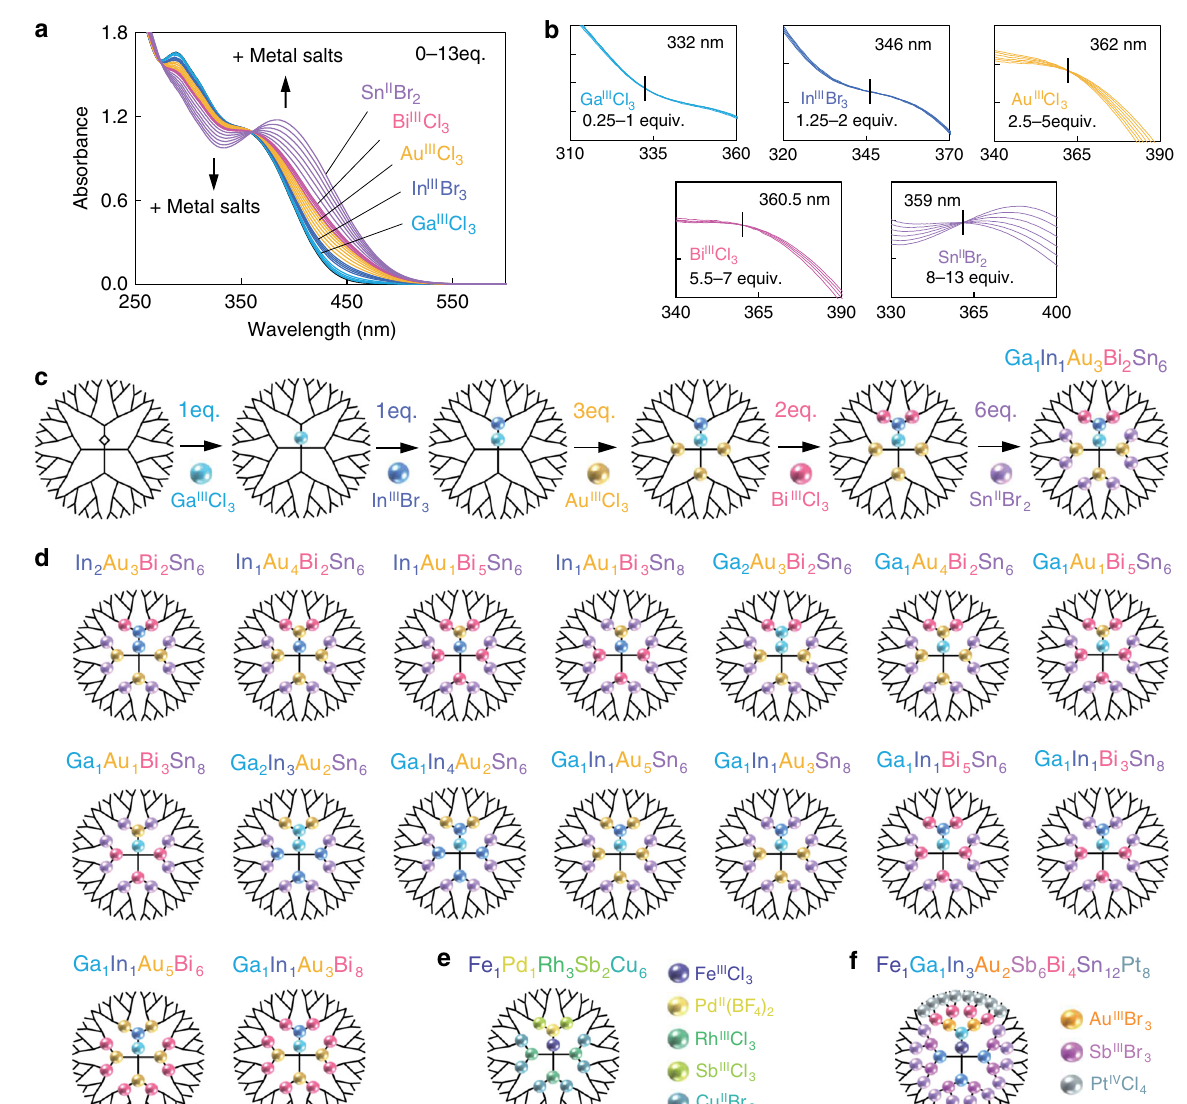
Fig. 3 Multimetallic accumulation on a dendrimer template. a Changes in UV-Vis absorption spectra of PyTPM-G4 upon addition of 1 equiv. Ga III Cl 3 , 1 equiv. In III Br 3 , 3 equiv. Au III Cl 3 , 2 equiv. Bi III Cl 3 , and 6 equiv. Sn II Br 2 in 1:1 DCM/AN. b Isosbestic points during complexation with metal salts in layers 0 – 1, 1 – 2, 2 – 5, 5 – 7, and 7 – 13. c Layer-by-layer stepwise multimetallic accumulation of metal salts on PyTPM-G4. d Diversity of multimetallic accumulation of four elements at amounts up to 13 equiv. e Multimetallic accumulation of fi ve elements (Fe III Cl 3 , Pd II (BF 4 ) 2 , Rh III Cl 3 , Sb III Cl 3 , and Cu II Br 2 ) at amounts up to 13 equiv. on PyTPM-G4. f Multimetallic accumulation of eight elements (Fe III Cl 3 , Ga III Cl 3 , In III Br 3 , Au III Br 3 , Sb III Br 3 , Bi III Cl 3 , Sn II Br 2 , and Pt IV Cl 4 ) at amounts up to 37 equiv. on